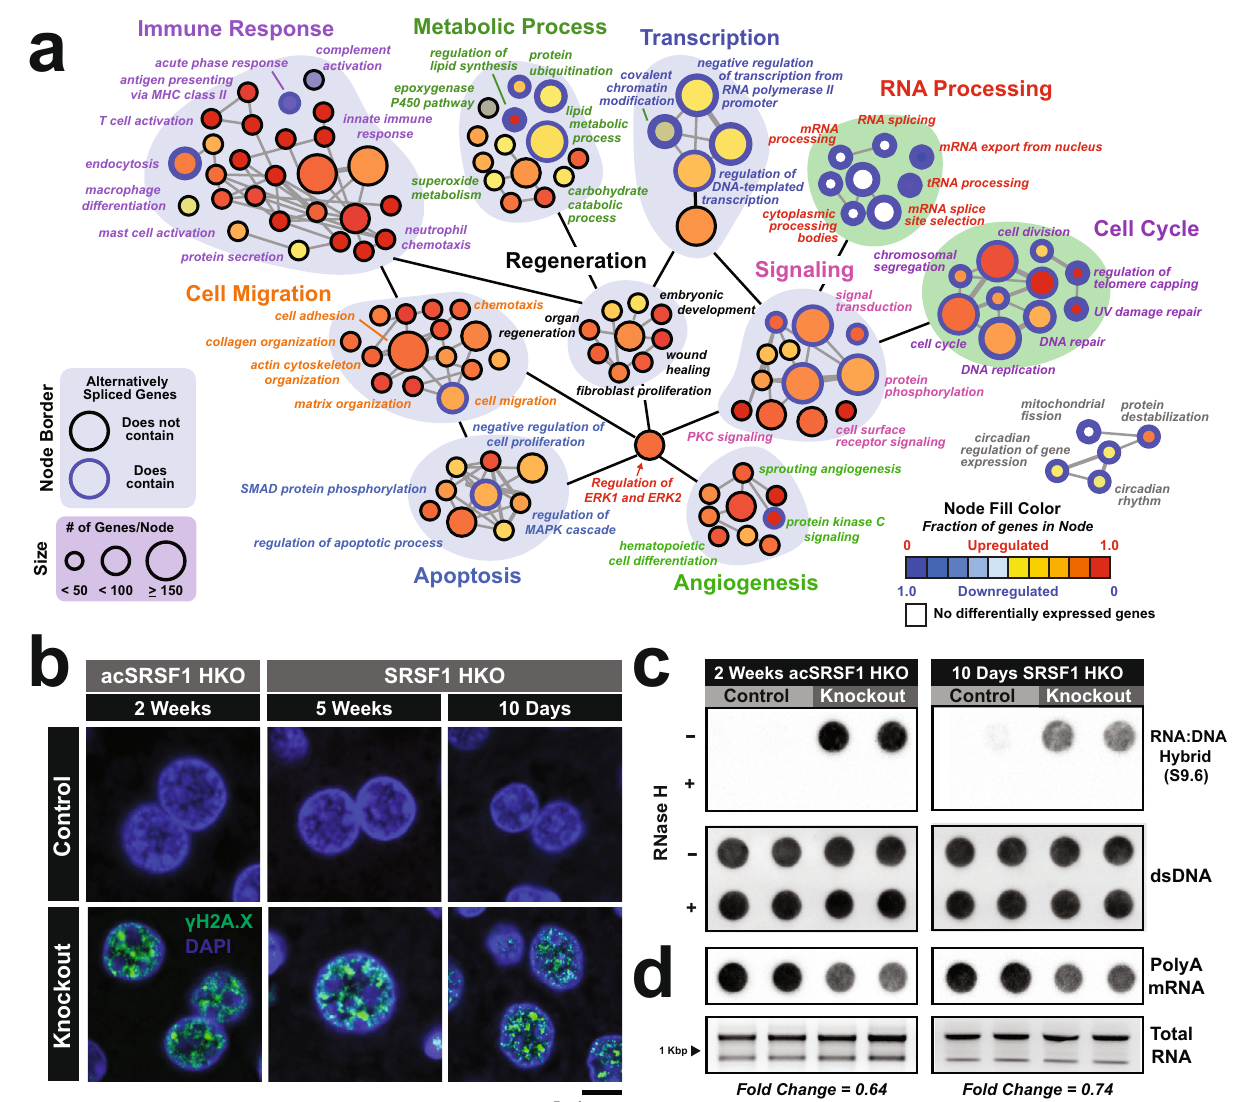
Fig.7|LossofSRSF1resultsinDNAdamagemediatedbyR-loopaccumulation. a Gene ontology network map showing biological processes enriched for genes with differential expression or exon splicing in acSRSF1 HKO hepatocytes. Each nodecorrespondstoanenrichedGOterm,withthesizeandcolorrepresentingthe number of genes within the node and the direction of differential expression, respectively. Nodes with blue outlines signify nodes that contain genes with dif- ferential splicing events in acSRSF1 HKO. b Representative IF images of liver sec- tions from acSRSF1 HKO and SRSF1 HKO ( n =5 per group for 2- and 5-weeks; n =4 per group for 10 days) at the indicated timepoints probed for γ H2A.x (green), a DNA damage marker, with nuclear counterstaining using DAPI (blue).